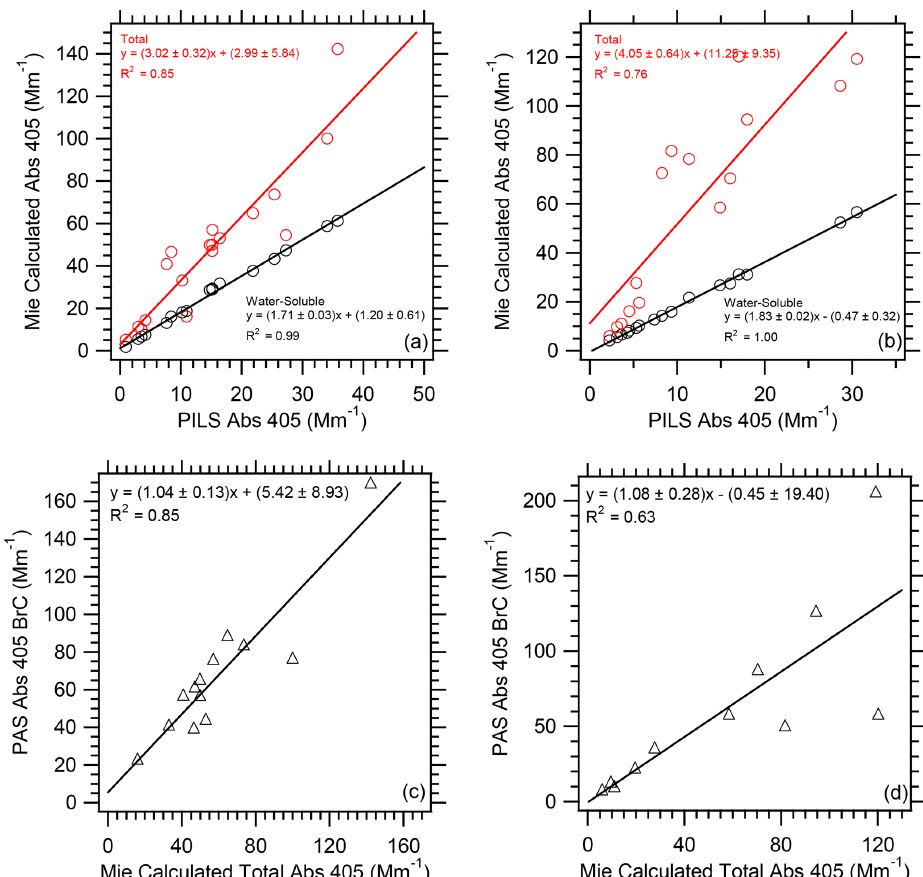
Figure 5. Correlation of Mie-calculated water-soluble and total Abs 405 vs. PILS water-soluble Abs 405 for WE-CAN (a) flight RF02 and (b) flight RF11. Correlation of PAS total Abs 405 BrC and Mie-calculated total Abs 405 for WE-CAN (c) flight RF02 and (d) flight RF11. Uncertainties with the least square regressions are 1 standard